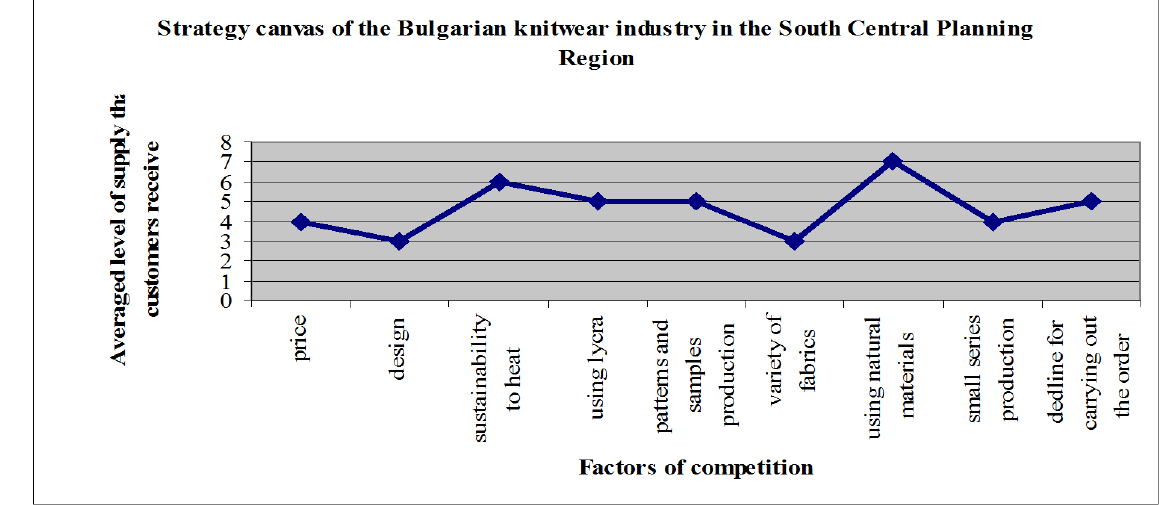
Fig. 2. The “Strategy Canvas” for a part of the Bulgarian knitwear